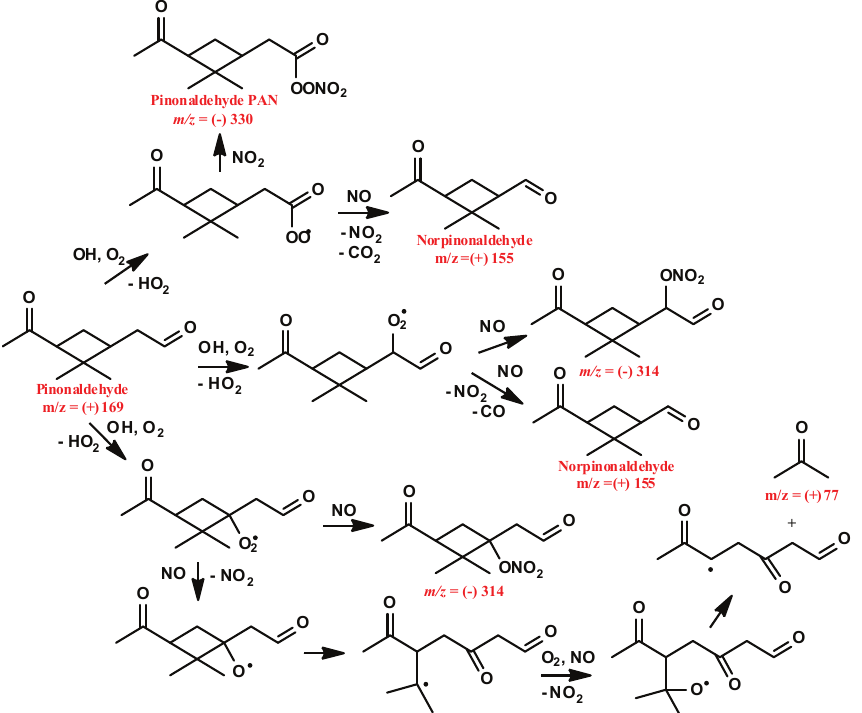
Fig. 8. Pathways of photooxidation of pinonaldehyde under high-NO x conditions, H-abstraction by OH occurs predominantly at the aldehydic carbon. Ion of compounds detected by CIMS are indicated in